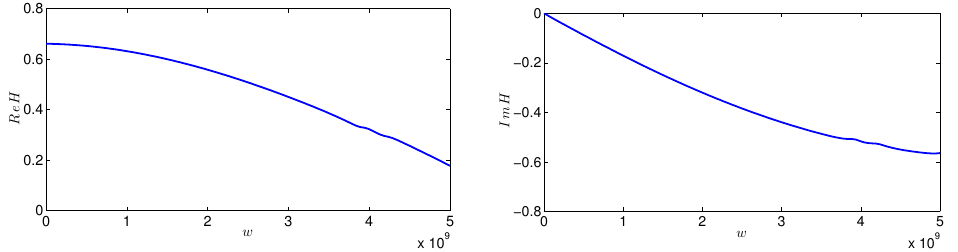
( w ) from the DDR4 module with a 32